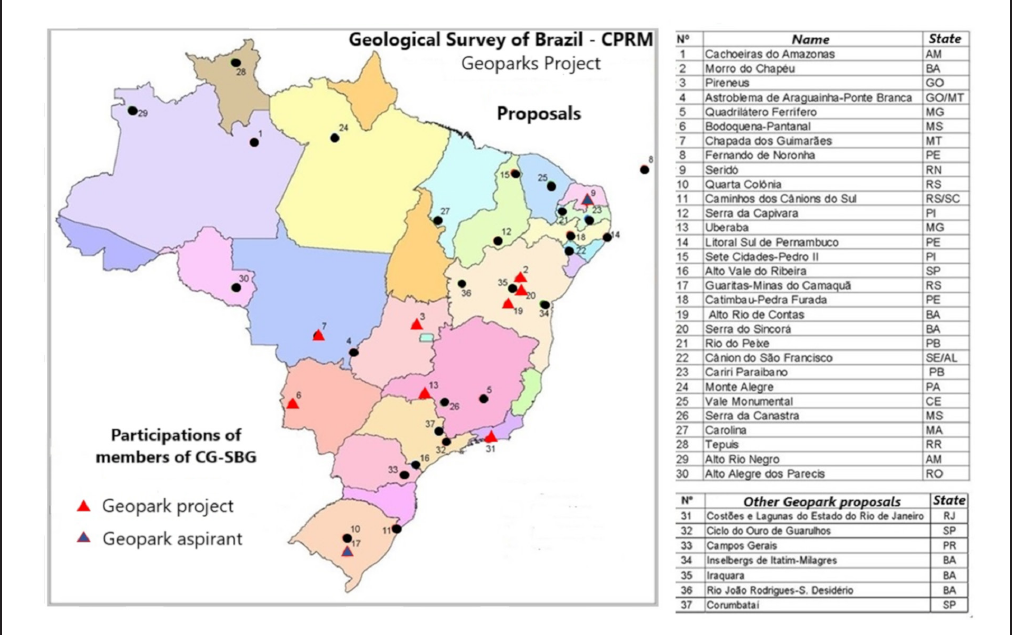
FIGURE 2 . Aspirants and geoparks projects with the participation of CG-SBG Members (modified from: http://www.cprm.gov.br/publique/ GestãoTerritorial/Geoparques-134). Aspirant Caçapava was treated by CPRM as Guaritas-Minas do Camaquã (number 17).